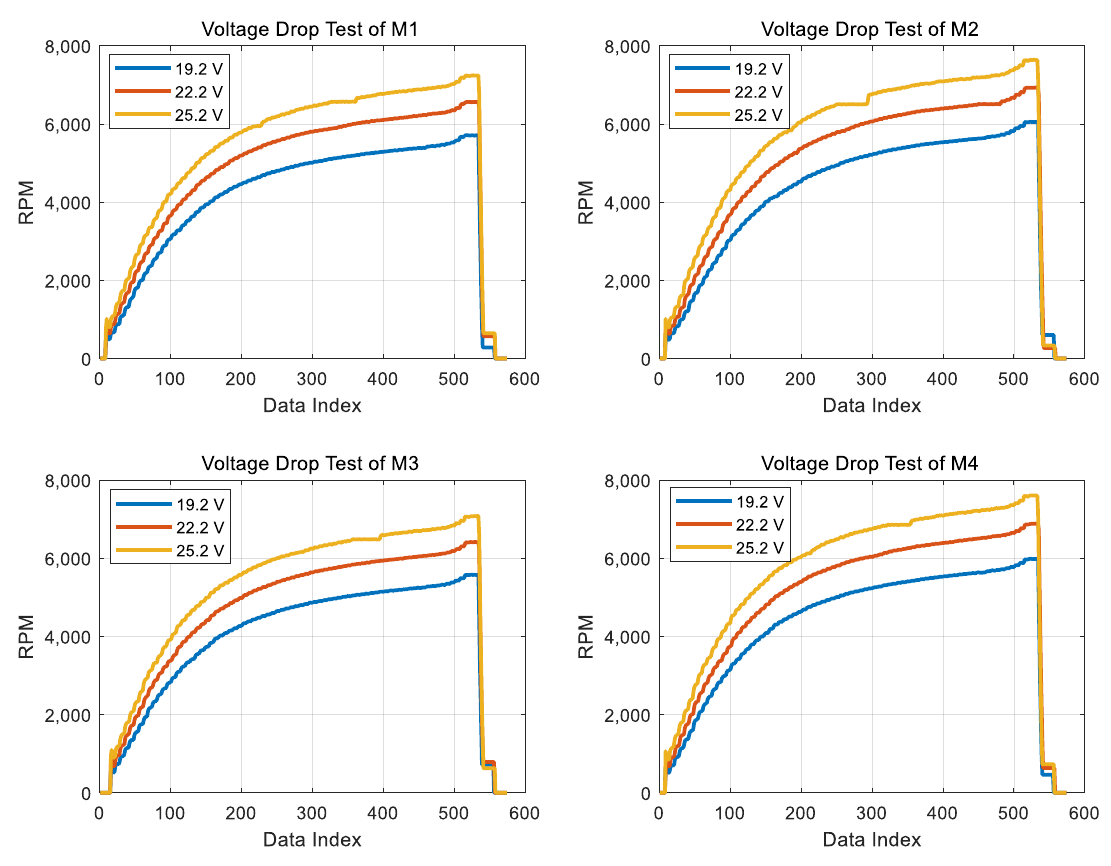
Figure 12. The Experiment E results of change operating voltages.